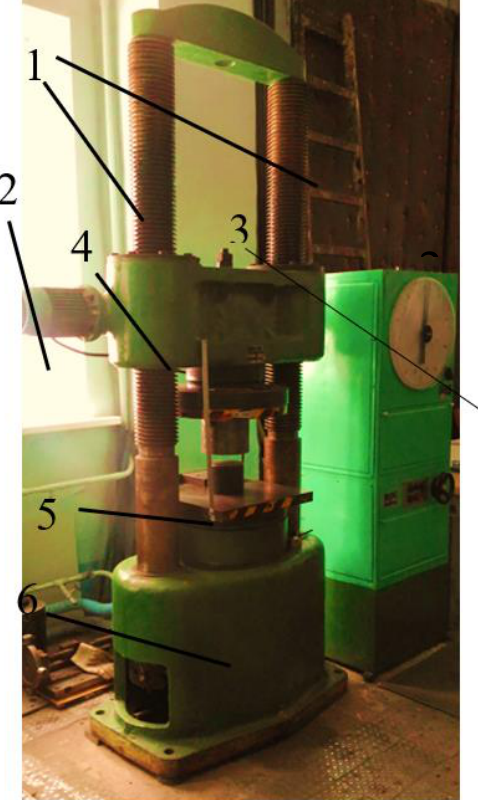
Figure 6. Hydraulic press PSU-250: 1 — screwed column; 2 — electric motor; 3 — analog dial; 4 — mo- bile traverse; 5 — top plate; 6 — bottom plate.